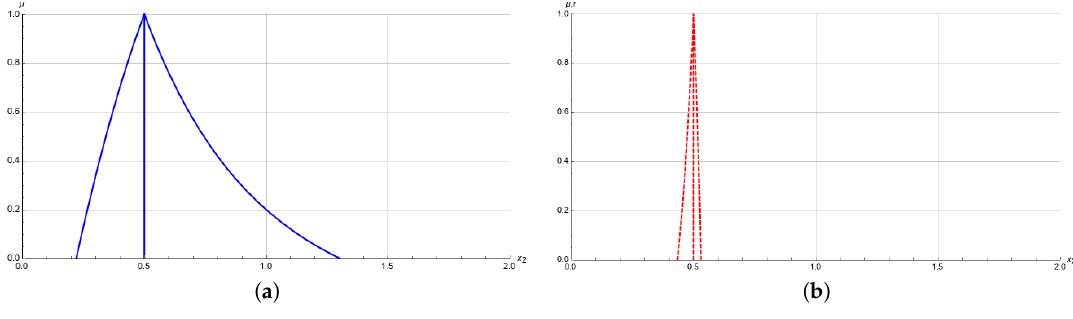
) of the positive root determined by MF-arithmetic ( a ) Figure 7. The span function s ( x gr 2 and with standard approach using Newton’s method [5,8] ( b ). ( a ) MF-arithmetic approach; ( b ) standard